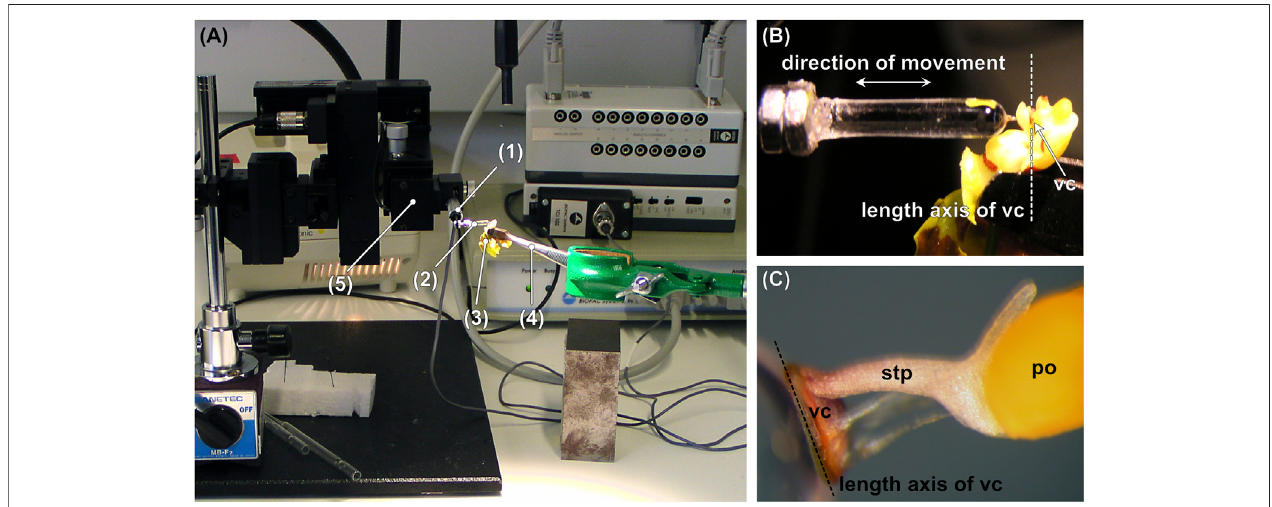
FIGURE 2 | (A) Test setup consisting of a pollinator-mimicking glass rod, which is mounted on a force transducer coupled to a motorized micromanipulator. (B) Detail of (A) showing the glass rod that is approached and retracted perpendicular to the length axis of the viscidium. (C) Pollinarium attached to the tip of the glass rod. po (cid:1) pollinium, stp (cid:1) stipe, vc (cid:1) viscidium. 1) Force transducer, 2) glass rod, 3) fl ower, 4) tweezers, 5) motorized